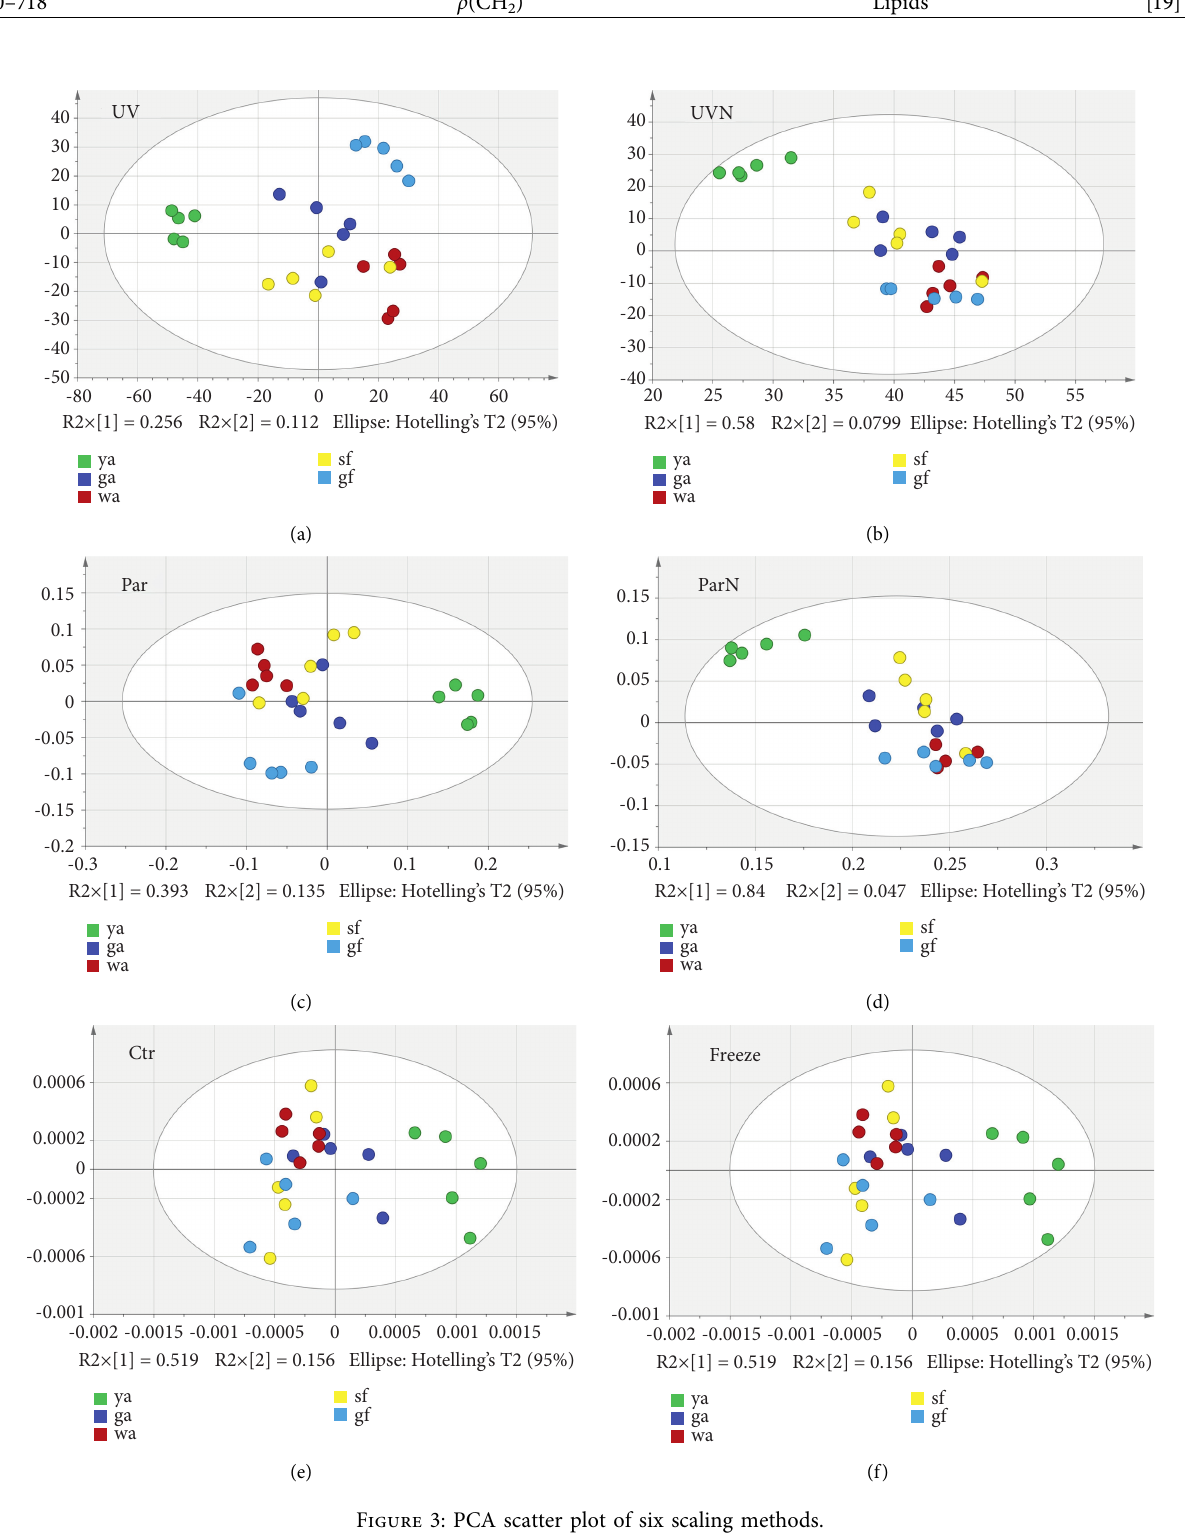
Figure 3: PCA scatter plot of six scaling